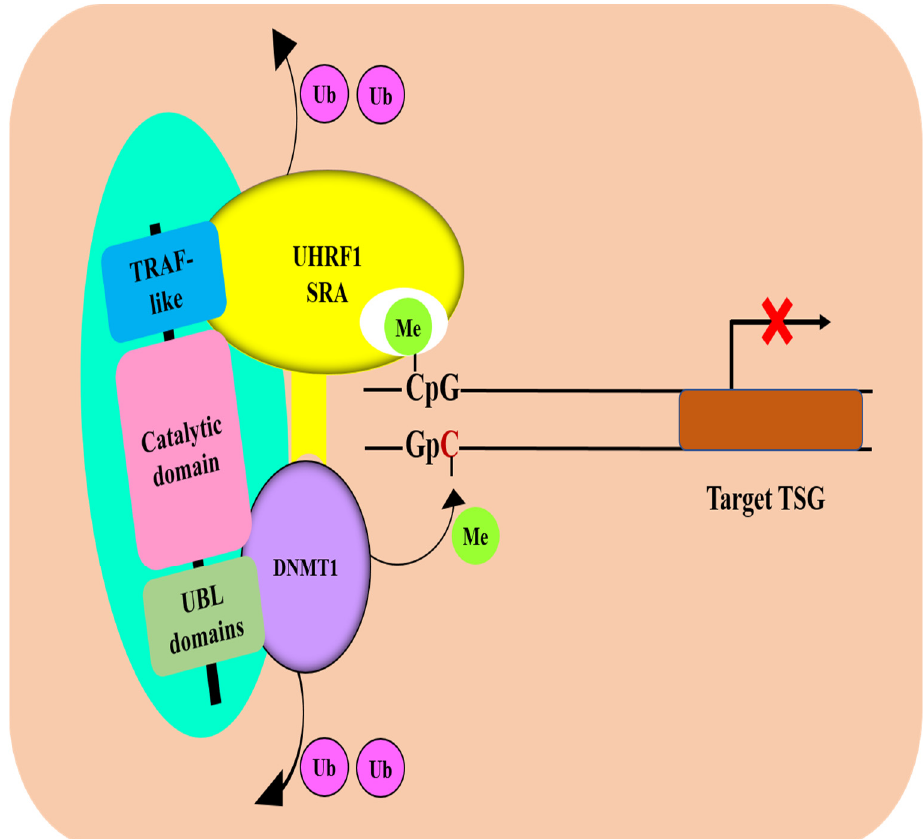
Figure 3. Schematic representation of role of HAUSP in DNA methylation maintenance through regulating the stability UHRF1/DNMT1 dual. HAUSP, via its UBL domains, interacts with the targeting sequence (TS) domain of DNMT1, whereas HAUSP, through its TRAF-like domain, interacted with the SET- and RING-associated (SRA) domain of UHRF1, thereby promoting the stability of UHRF1 and DNMT1 through HAUSP-dependent deubiquitination [38]. The trimeric complex located at promoter regions of target TSGs on chromatin. During DNA replication, the SRA domain of UHRF1 can read methylated CpG sites (hemi-methylated DNA) located within the promoter regions and via the same SRA domain, UHRF1 recruits DNMT1 and guide it to methylate the “unmethylated “cytosine of the newly synthetized DNA strand leading to hypermethylation of TSG promoter.